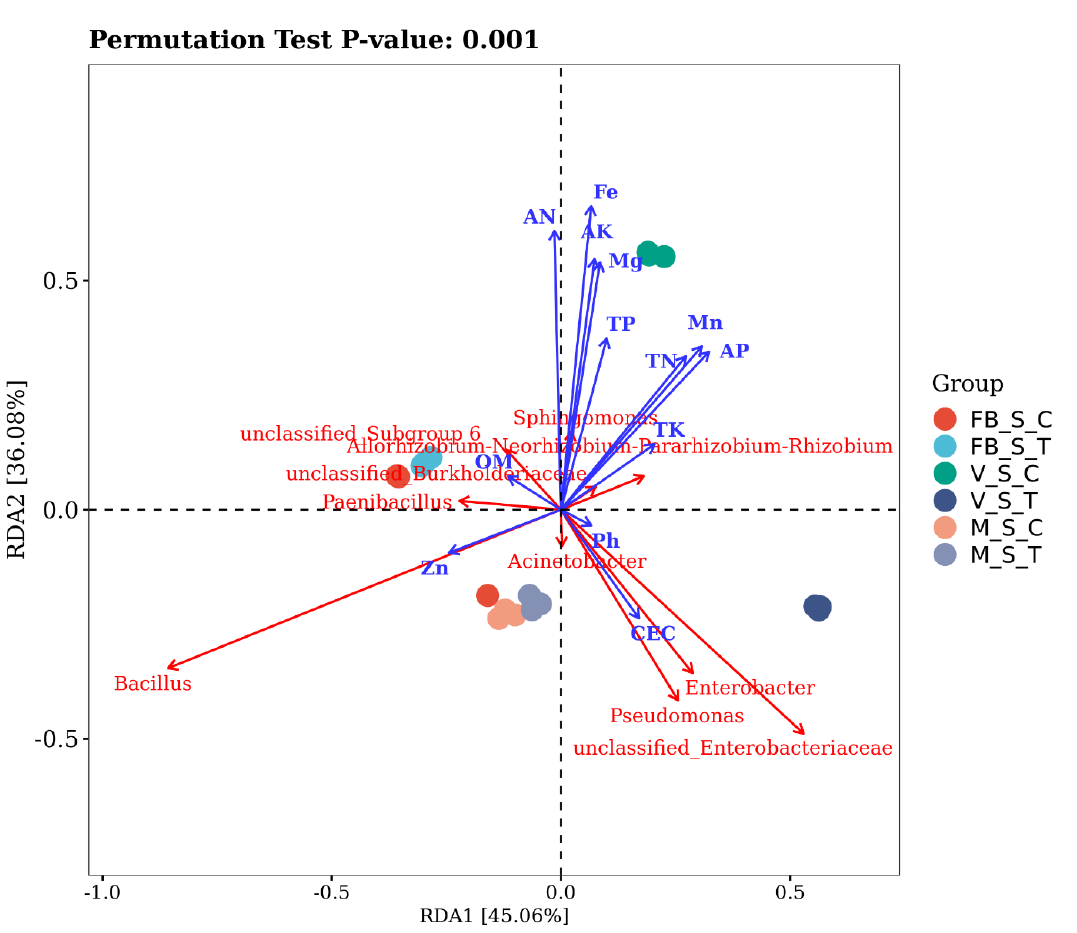
Figure 4. The sampling groups depicted in the colour dots, soil parameters with blue arrows and the most affected are mentioned in red colour. The smaller the p -value, the greater the significant impact of the overall influencing factors on the composition of the soil microbiota. The network analysis method was employed to investigate the connection between bacterial genera and the edaphic soil factors, along with the influence of the nutritional profile of the soil affecting the bacterial population density. The structuring was signifi- cantly different in both the control and treated plants. A correlation was also noticed be- tween the soil edaphic factors, corresponding to their abundance and jointly venturing towards bacterial networking. According to our sieving conditions of the constituted network r > 0.6 or r < −0 .6 and p < 0.05, we observed 1072 (179 − ve, 893 + ve) effective interactions in control plants while 994 (463 − ve, 531 + ve) interactions were recorded in the treated plants. The analysis was performed on the genus (Supplementary Materials Figure S8) and phylum levels. The co- occurrence network was compartmentalized into clusters connecting the edaphic factors as the bacterial niches. According to the network diagram of control plants (Figure 5a), it was observed that there is a correlation among the soil elements, and they are mutually steering the community configuration. The correlation between AN and AK was r 2 = 0.9; p > 0.0009, Mg and AN were r 2 = 0.93; p > 0.0002, while Mg and AK were r 2 = 0.83; p > 0.005. The maximum number of nodes were related to Firmicutes, Proteobacteria, Acidobacteria, Actinobacteria and Bacteroidetes . TK was reported to influence the genera under the Bac- teroidetes and Dababacteria significantly. TP, Mn and Zn were correlated with Cyanobac- teria . CEC, OM and AP governed Chloroflexi and Planctomycetes.